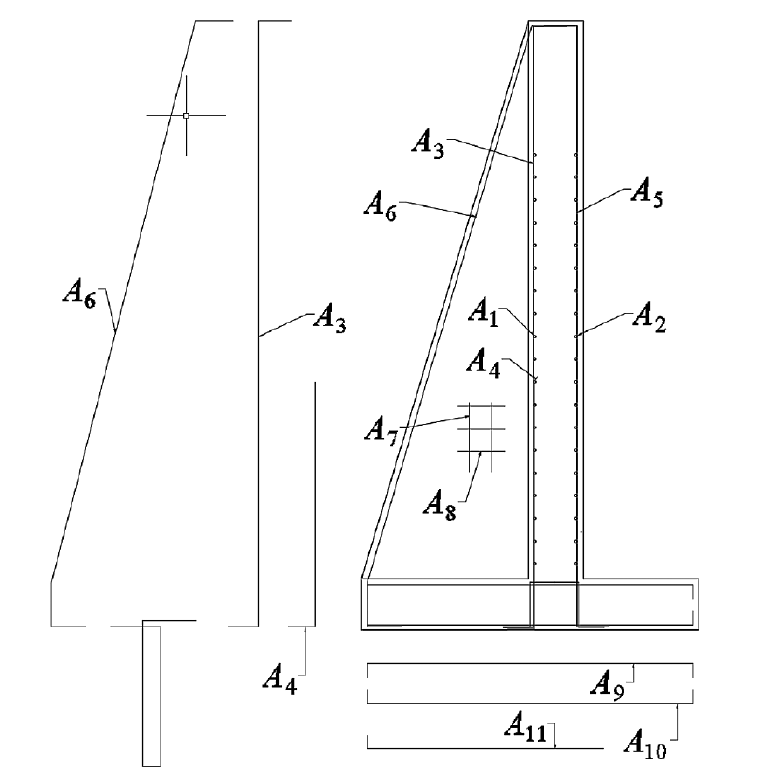
Figure 2. Reinforcement variables for the design of earth-retaining walls